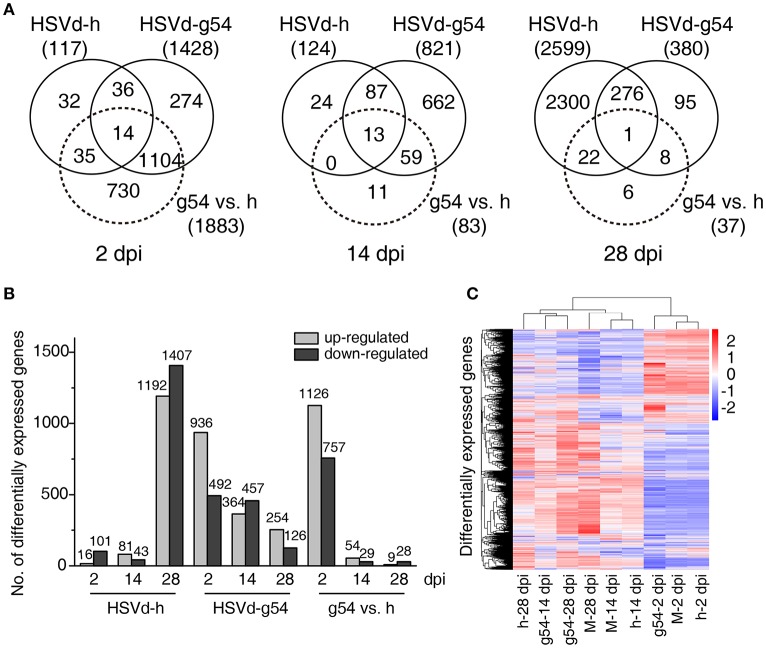
Comparison of differentially expressed genes (DEGs) in response to HSVd-g54 and HSVd-h infection of cucumber. (A) Venn diagrams showing unique and common DEGs in different comparisons at 2, 14, and 28 dpi. (B) The number of up- and down-regulated DEGs in different comparisons. (C) A heat cluster map of cucumber DEGs resulting from HSVd infection. Red, up-regulated genes; blue, down-regulated genes; the red and blue colors represent the values of log10(FPKM + 1) from high to low. M, mock infected plants; h, HSVd-h; g54, HSVd-g54.